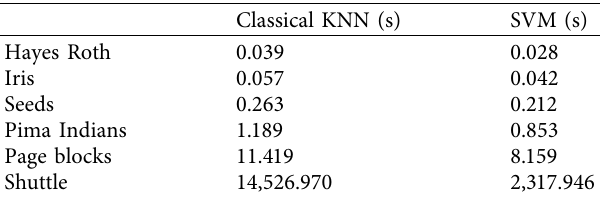
Table 2: Comparison of classification time between classical KNN and SVM (unit: